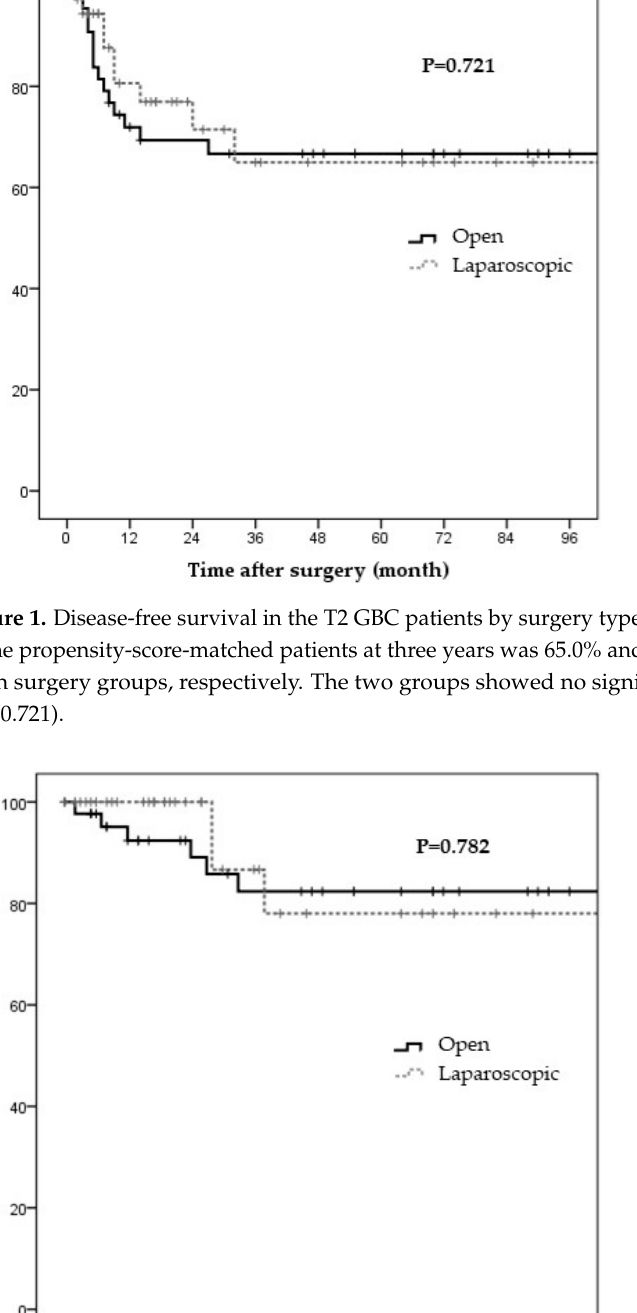
Figure 2. The cancer-specific survival rate in T2GBC patients by surgery type. The cancer-specific survival rates in the propensity-score-matched patients at three years were 78.0% and 82.4% in the laparoscopic and open surgery groups, respectively. No significant differences were observed between the laparoscopic and open surgery groups ( p = 0.782) in terms of survival.